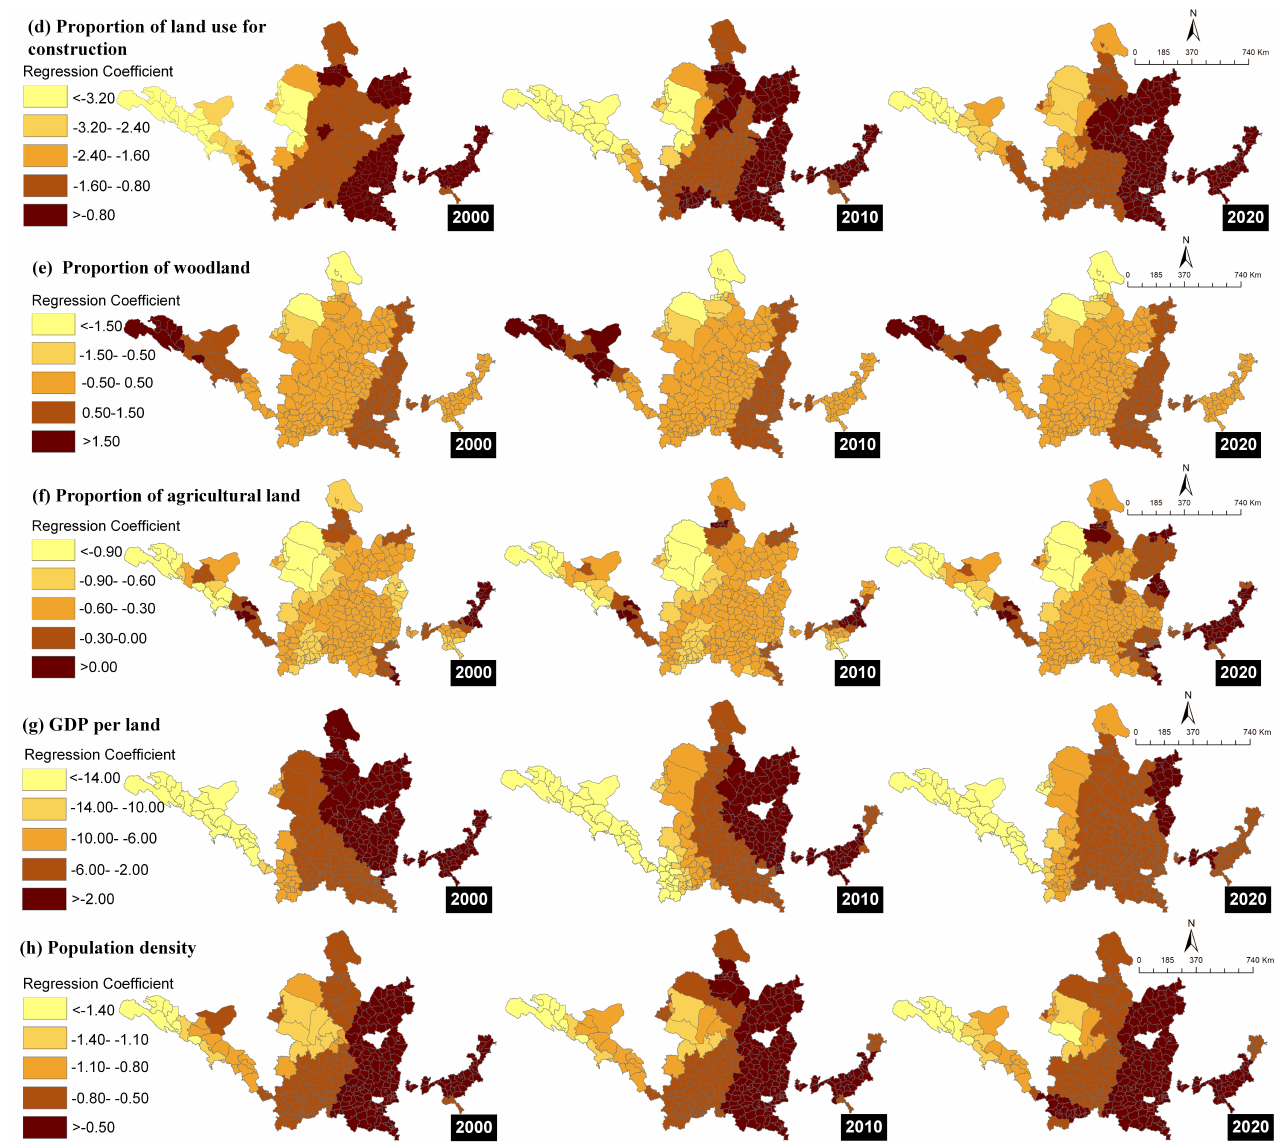
Figure 8. Spatial distribution of impact factor regression coefficients from